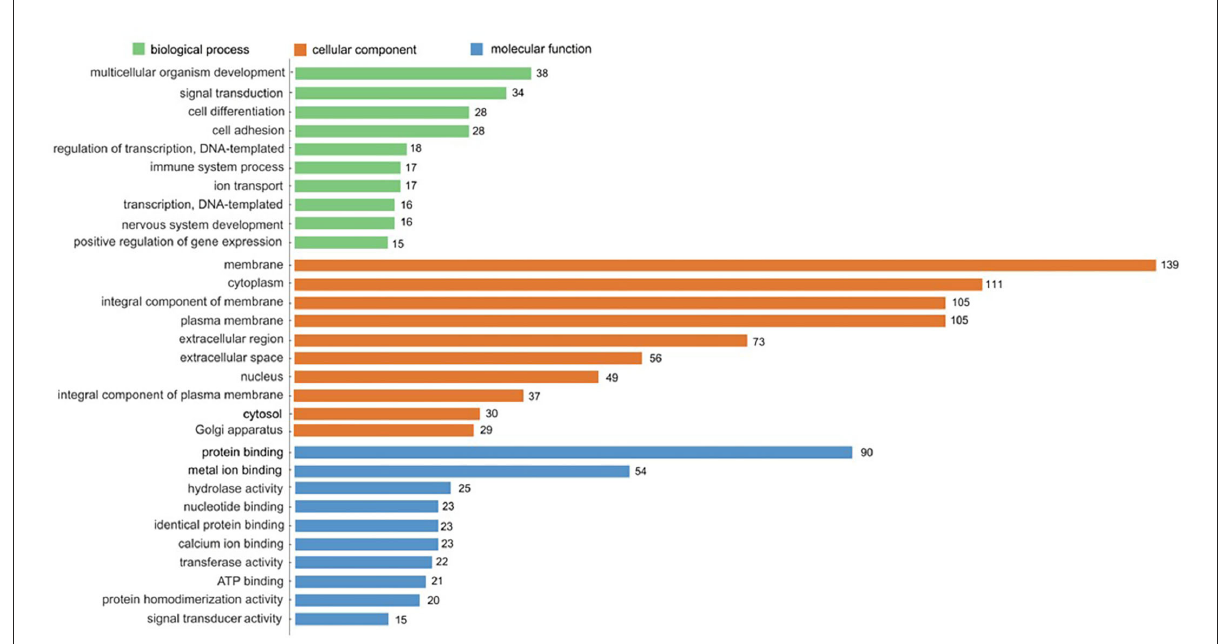
FIGURE8 GO enrichment analysis of DEGs. The top 10 enriched in cellular component, molecular function, and biological process,